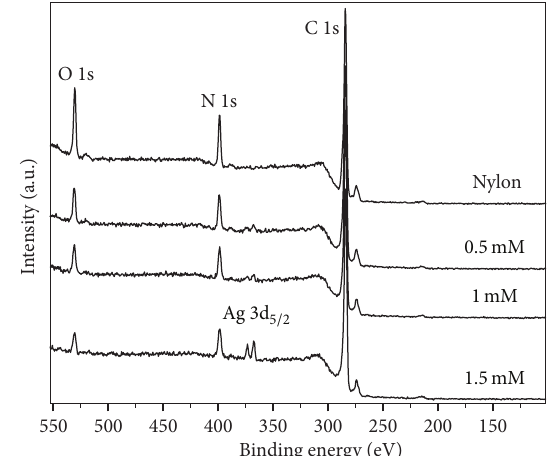
Figure 9: XPS spectra of nylon-6,6 and three different nylon-6,6/Ag